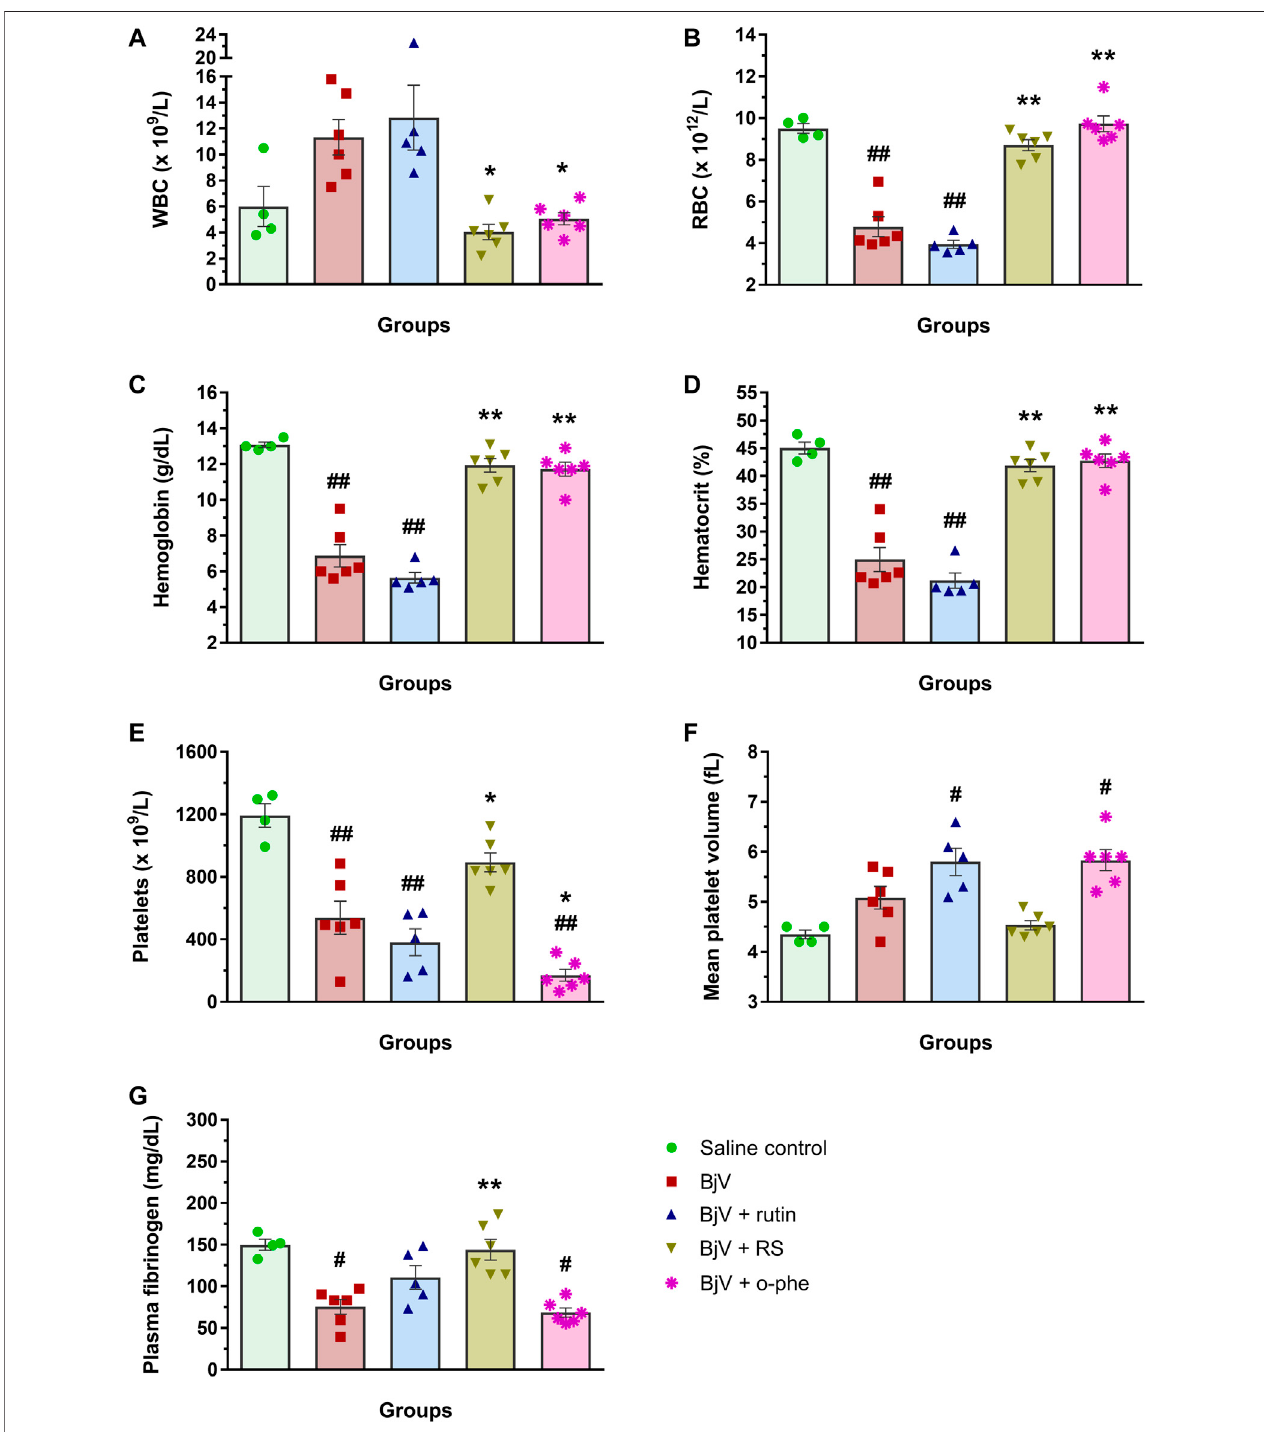
FIGURE 12 | (A) WBC counts, (B) RBC counts, (C) hemoglobin, (D) hematocrit, (E) platelet counts, (F) MPV and (G) plasma fi brinogen in mice 48 h after the injection of saline, BjV, BjV + rutin, BjV + RS or BjV + o-phe (BjV dose: 2×LD 50 ). One-way ANOVA was used, followed by Bonferroni post-hoc test; # p < 0.05 and ## p < 0.001 when compared to saline control group; * p < 0.05 and ** p < 0.001 when compared to BjV group. Data are expressed as mean ± SEM. ( n = 4 – 6/group).